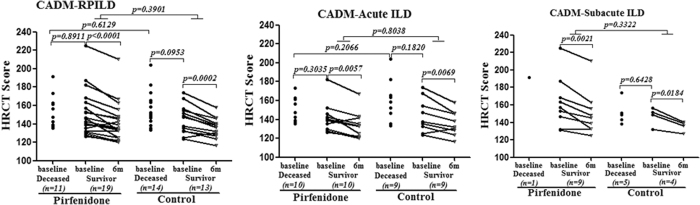
The overall HRCT score at baseline and its changes at 6 months among survivors.The baseline level did not significantly differ between the pirfenidone and control groups or the deceased and survivor groups.